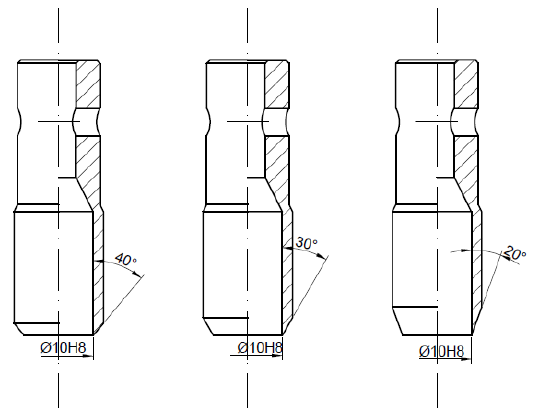
Figure 8. Third series of tested tools—piercing punches with the cutting edge towards the outside with a constant diameter and variable angle of the blade.